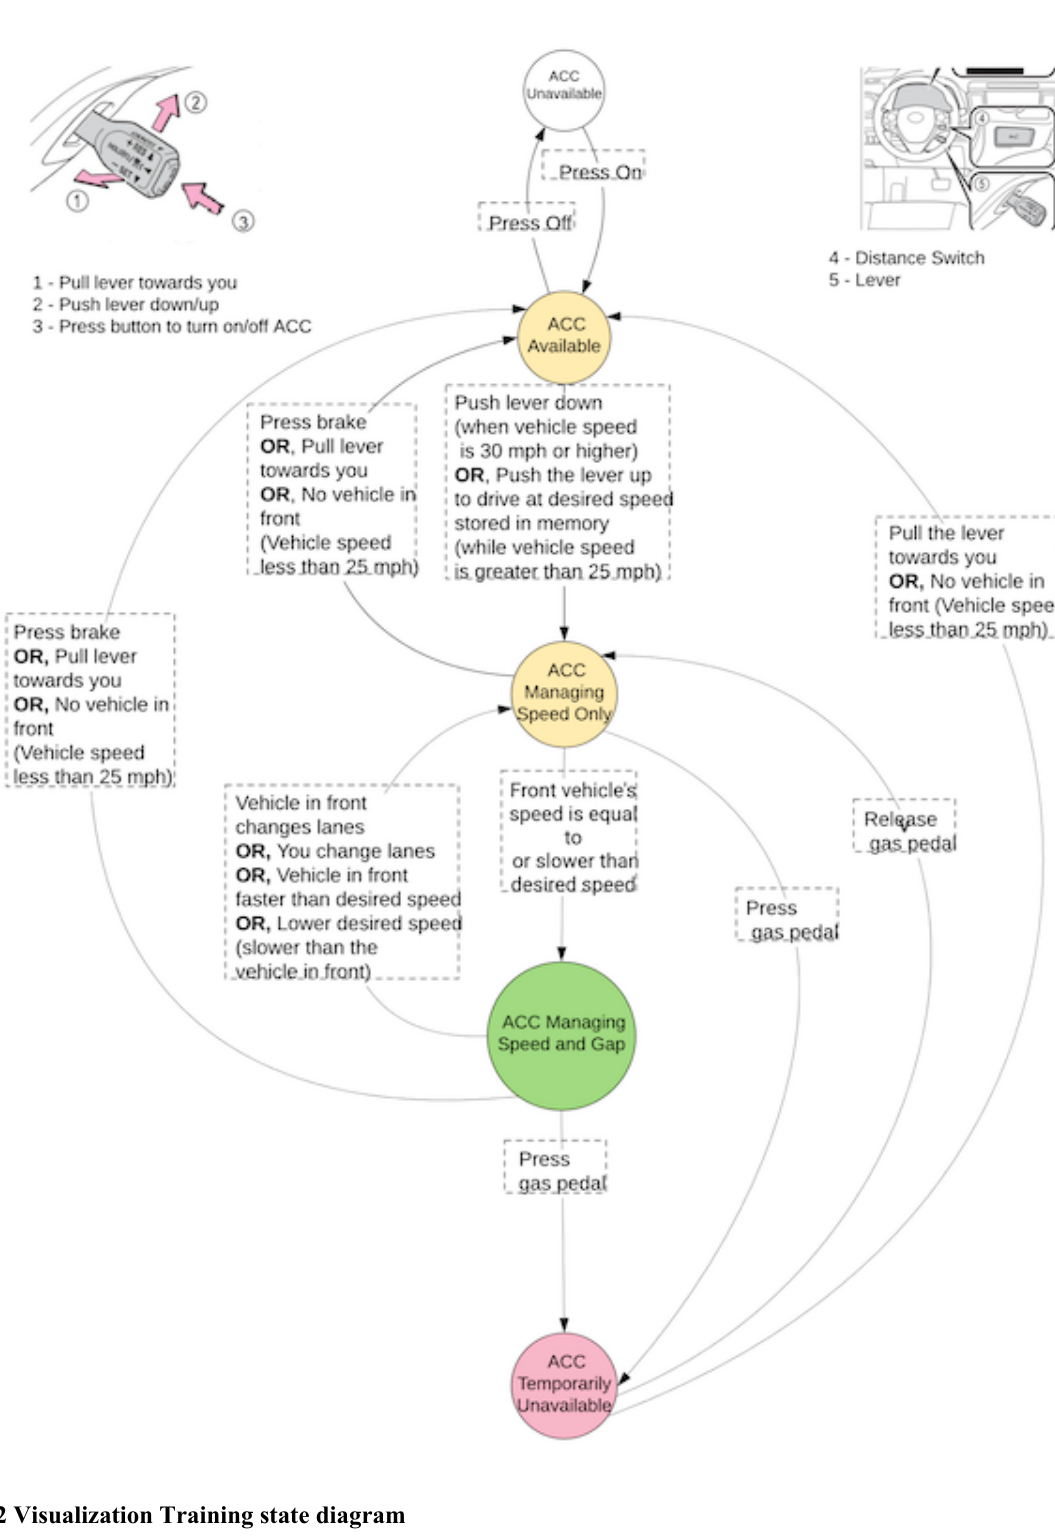
Figure 2 Visualization Training state diagram